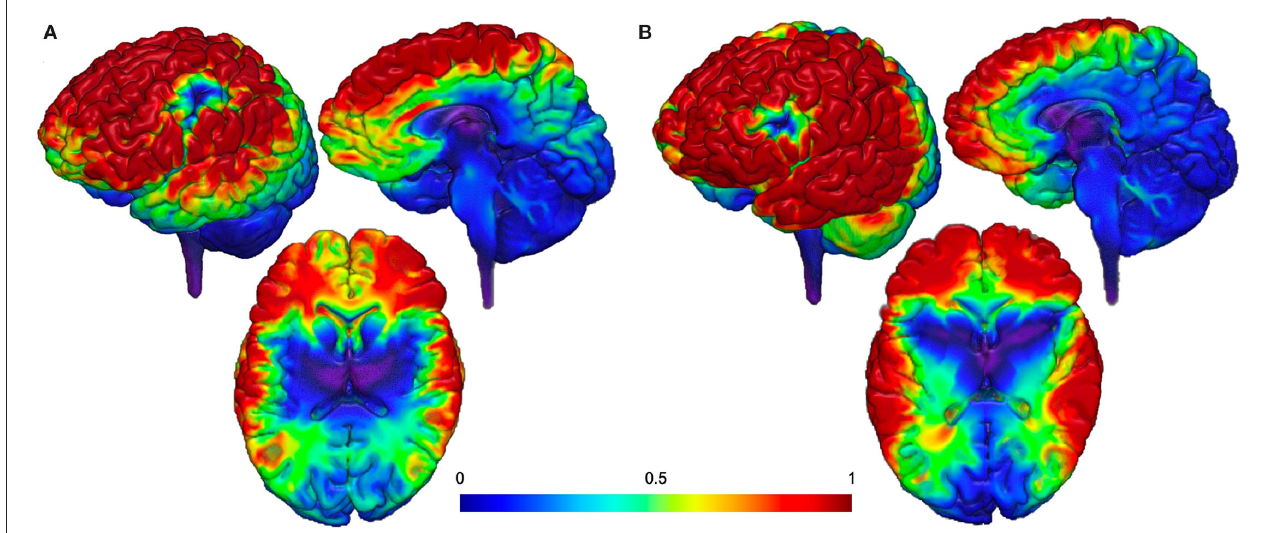
FIGURE 1 | Proposed theoretical electrical field models (113). (A) Targeting dACC stimulation and (B) targeting AIns stimulation. Both models demonstrate additional delivery of a strong electrical field to the superficial cortical areas between the TMS coil and the deeper brain target.